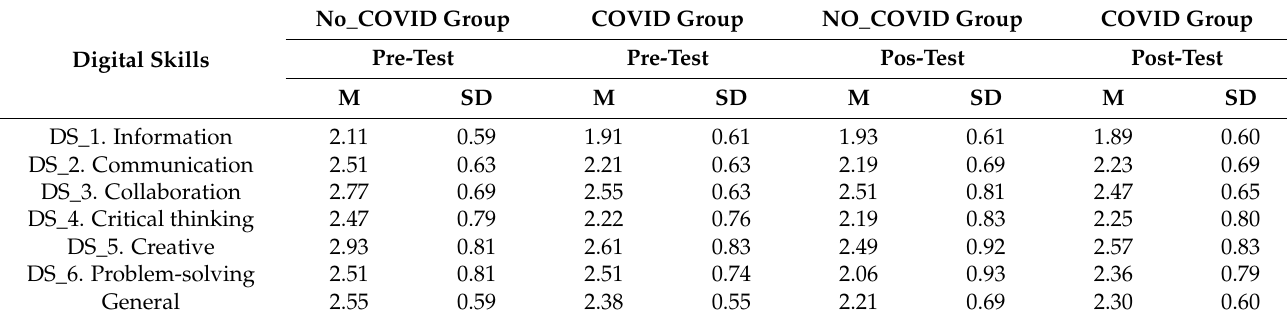
Table 5. Mean and standard deviation for both